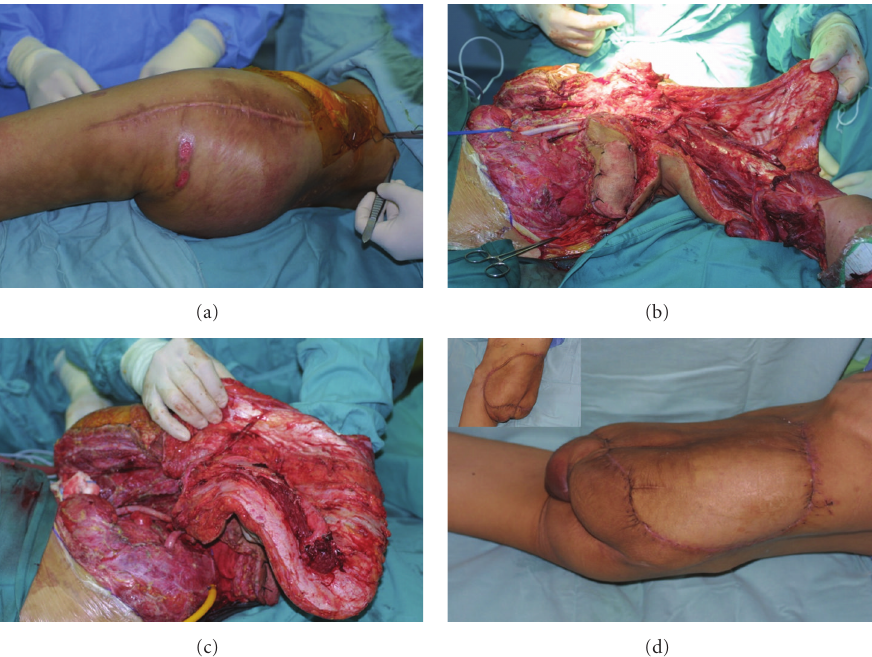
Figure 3: Case of 24-year-old lady with recurrent osteosarcoma previously treated with limb sparing surgery and modified hip arthroplasty, completed radiotherapy and chemotherapy. She had recurrent eight months later and external hemipelvectomy was done. (a) Preprocedure showing large swelling left buttock area. (b) The fasciocutaneous flap over the anterolateral thigh is raised on its pedicle-lateral circumflex femoral vessels. (c) Flap has been completely raised on its pedicle and inset. (d) Lateral and anteroposterior view one month post